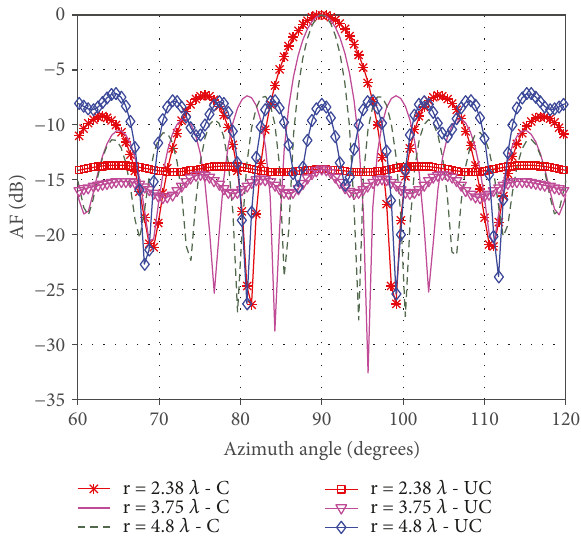
Figure 4: Array factors of the ULA when bent into arcs of di ff erent radii (legend entries: C indicates compensated; UC indicates uncompensated).